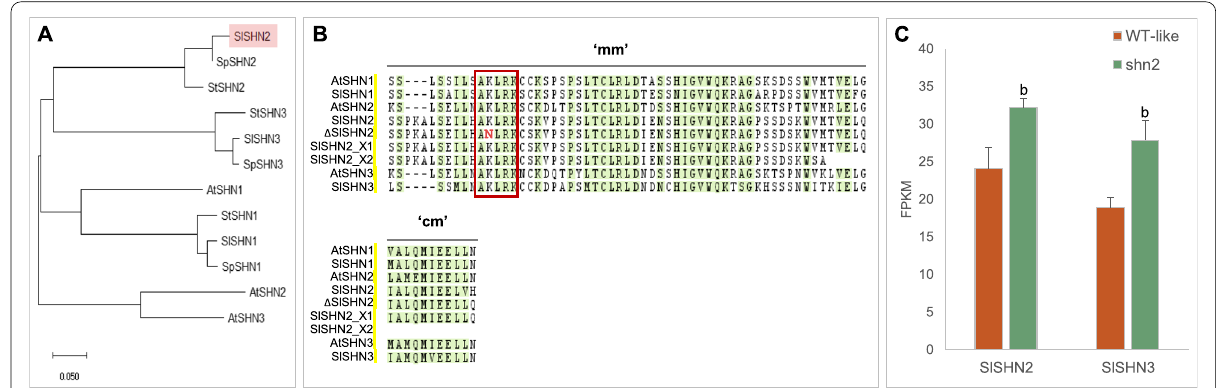
Fig. 2 The amino acid mutated in SlSHN2 is located in a conserved middle motif of SHN. A Neighbour joining phylogenetic tree of SHN proteins from Arabidopsis thaliana ( At ), Solanum lycopersicum ( Sl ), Solanum pennellii ( Sp ) and Solanum tuberosum ( St ) species using MEGA11 (Tamura et al. 2021). AtSHN1, AT1G15360; AtSHN2, AT5G11190; AtSHN3, AT5G25390. SlSHN1, Solyc03g116610; SlSHN2, Solyc12g009490; SlSHN3, Solyc06g053240; SpSHN1, Sopen03g035520; SpSHN2, Sopen12g004490; SpSHN3, Sopen06g018310; StSHN1, Sotub03g030060; StSHN2, Sotub12g008480; StSHN3, Sotub06g017730. B Multiple sequence alignment of the characteristic conserved middle motif (termed ‘mm’) and C-terminal motif (termed ‘cm’) of SHN proteins using CLUSTALW (Larkin et al. 2007); 100% similar amino acids are indicated in pale green. The red box surrounds the conserved motif AKLRK. The mutated amino acid in the shn2 mutant (ΔSHN2) is indicated in red. C Comparison of the expression of SlSHN2 and SlSHN3 genes in the WT-like and shn2 mutant exocarp of 20 DPA fruit. Mean values of 3 biological replicates are given in FPKM with SD. b, P < 0.05 (Student’s t